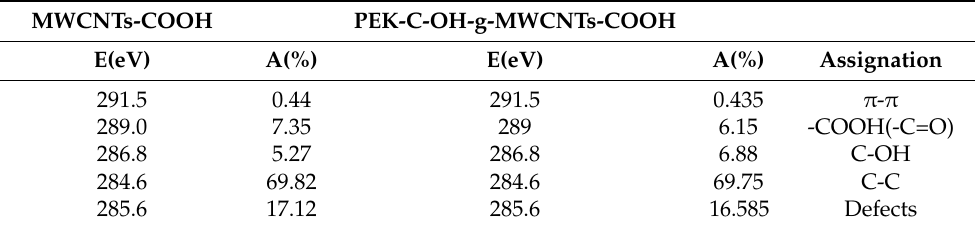
Table 3. XPS results: C1s peak positions E, areas A and